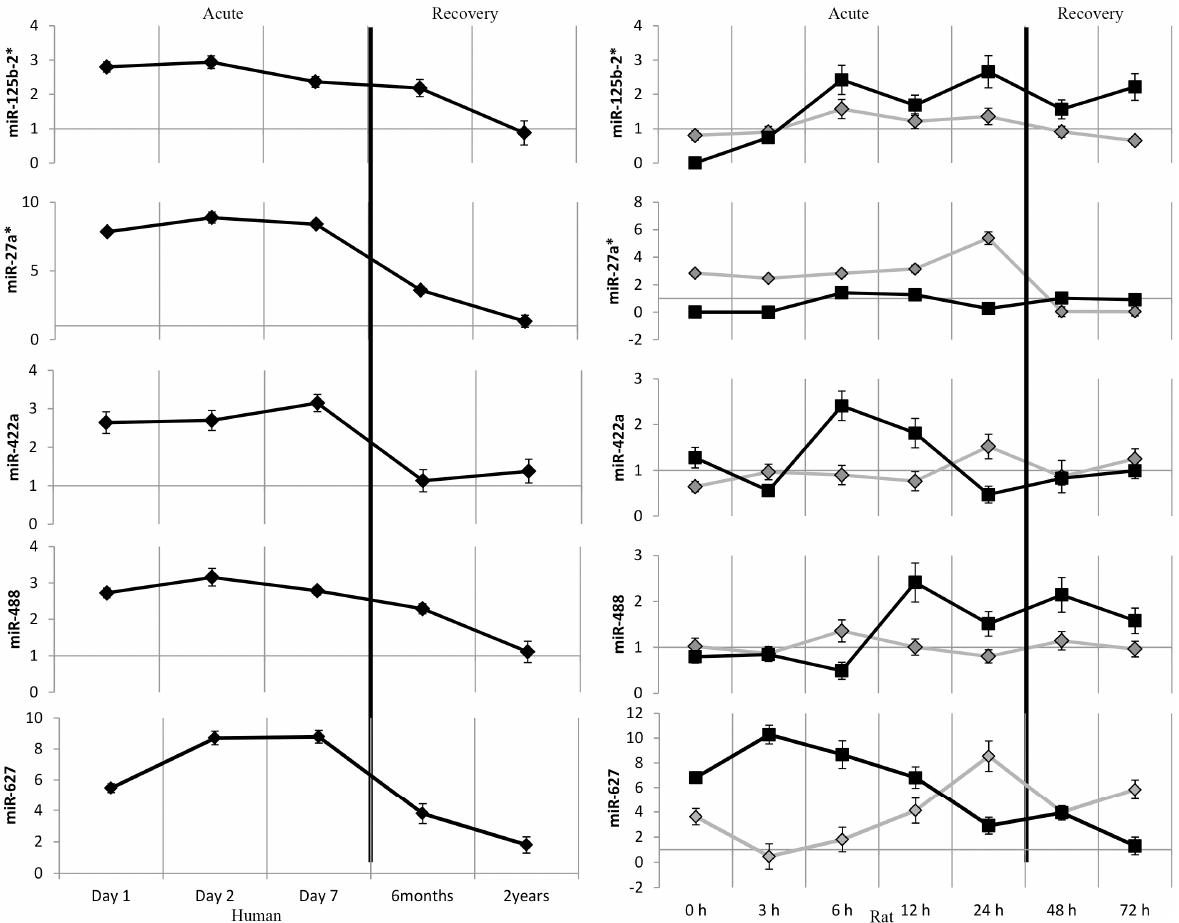
Figure 4. Relative miRNA expression in stroke patients and ischemic rodent